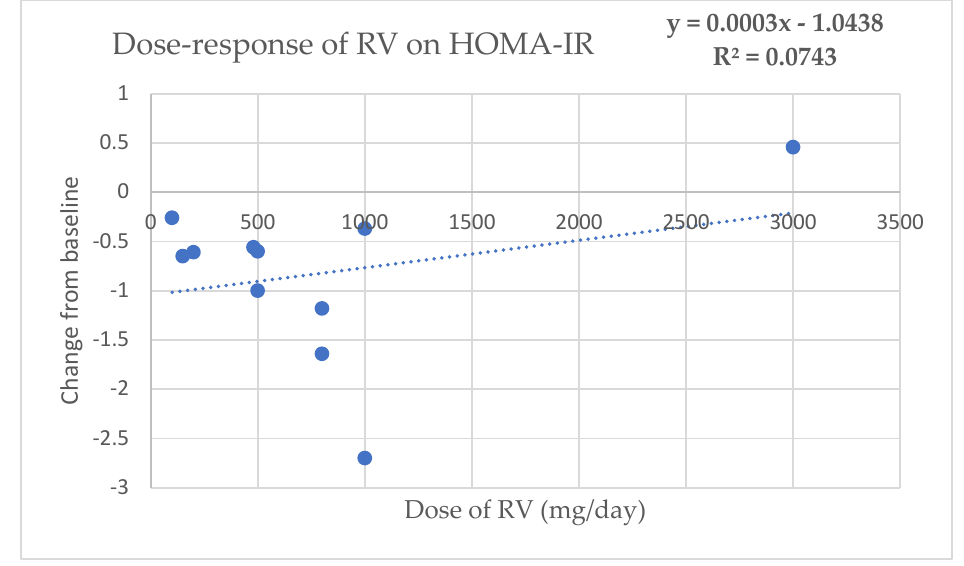
Figure A4. Dose–response regression analysis to assess the effect of RV on HOMA ‐ IR.